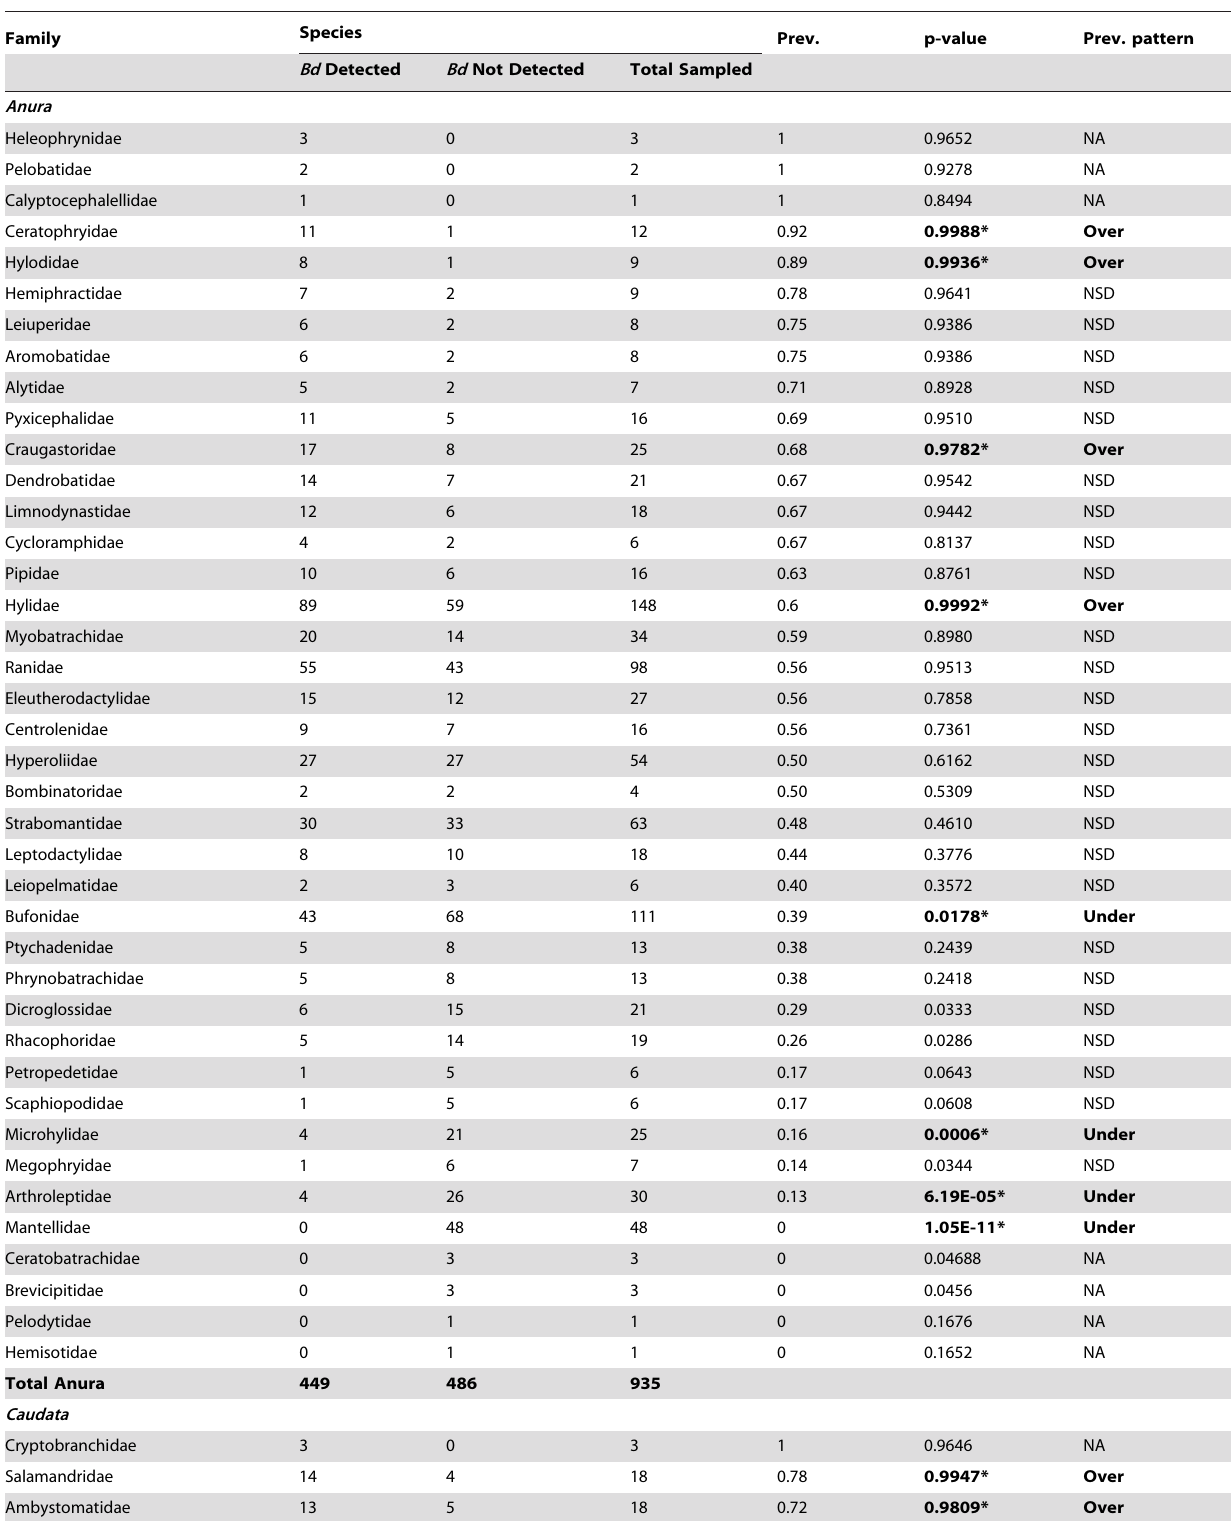
Table 2. Numbers of species with Batrachochytrium dendrobatidis ( Bd ) detections by amphibian family, and results of randomisation tests (see Materials and Methods section) to determine whether each sampled amphibian family was over- or under-infected, compared to what we would expect by chance given an overall prevalence of 508/1055 species.